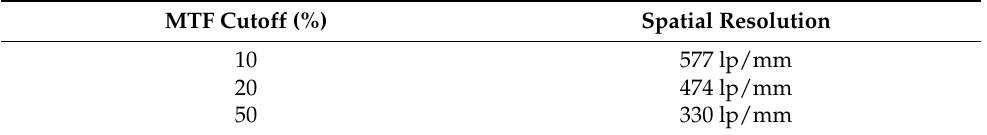
Figure 4. ( A ) R1L3S5P resolution test target, ( B ) Slanted test image (red rectangle from resolution target), ( C ) Modulation transfer function (MTF). Table 1. Spatial resolution metrics for different frequency cut-offs of the Modulation Transfer Function derived from a slanted edge test.